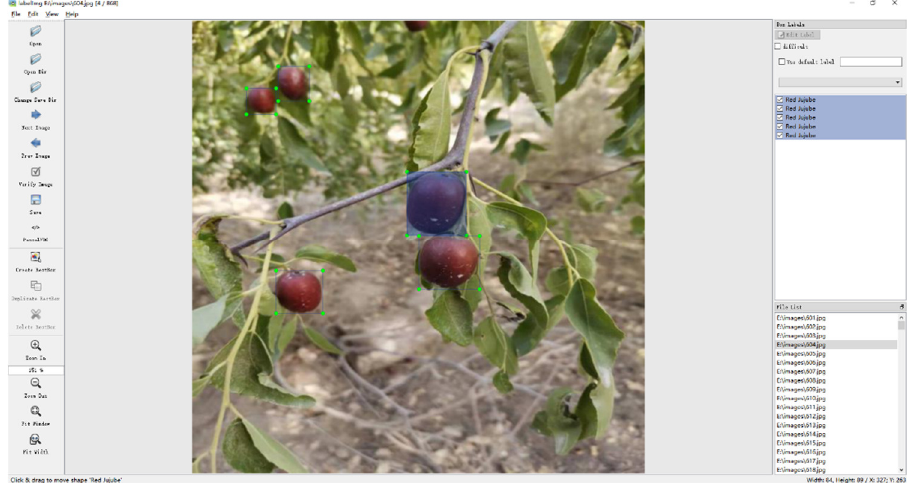
Figure 3. LabelImg data set